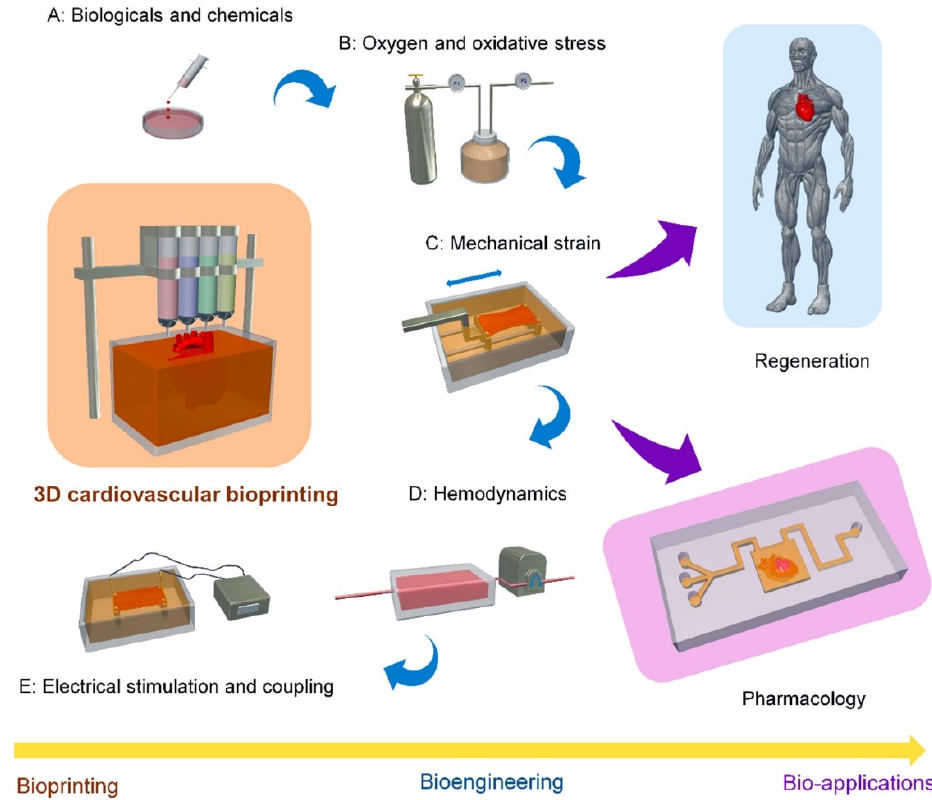
Figure 15. Schematic diagram outlining the techniques for 3D cardiovascular bioprinting, bioengi- neering methods, and bio-applications in regeneration and pharmacology. Reprinted with permis- sion from Cui et al. [94].